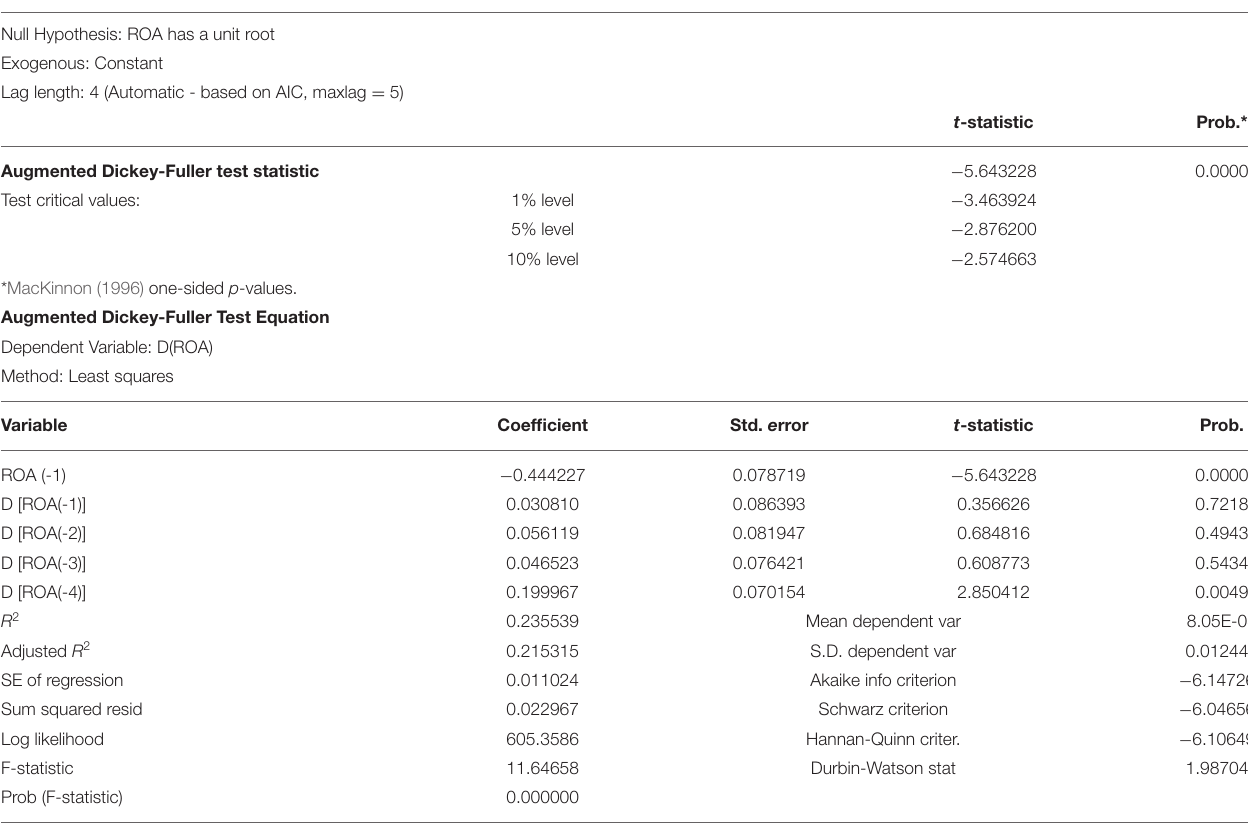
TABLE 8 | Augmented Dickey-Fuller